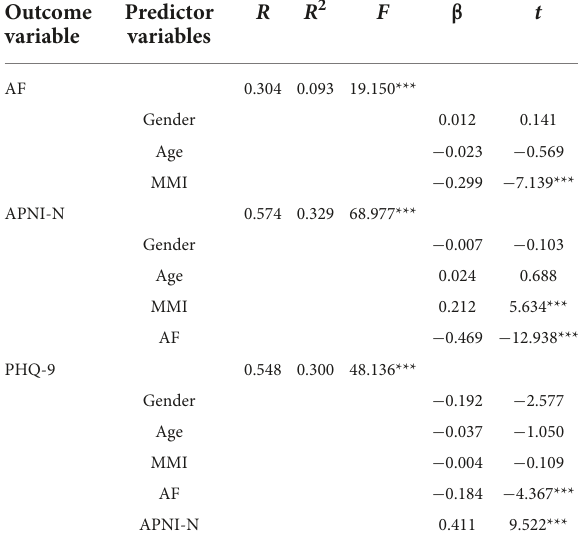
TABLE 4 Regression analysis of variable relationships in